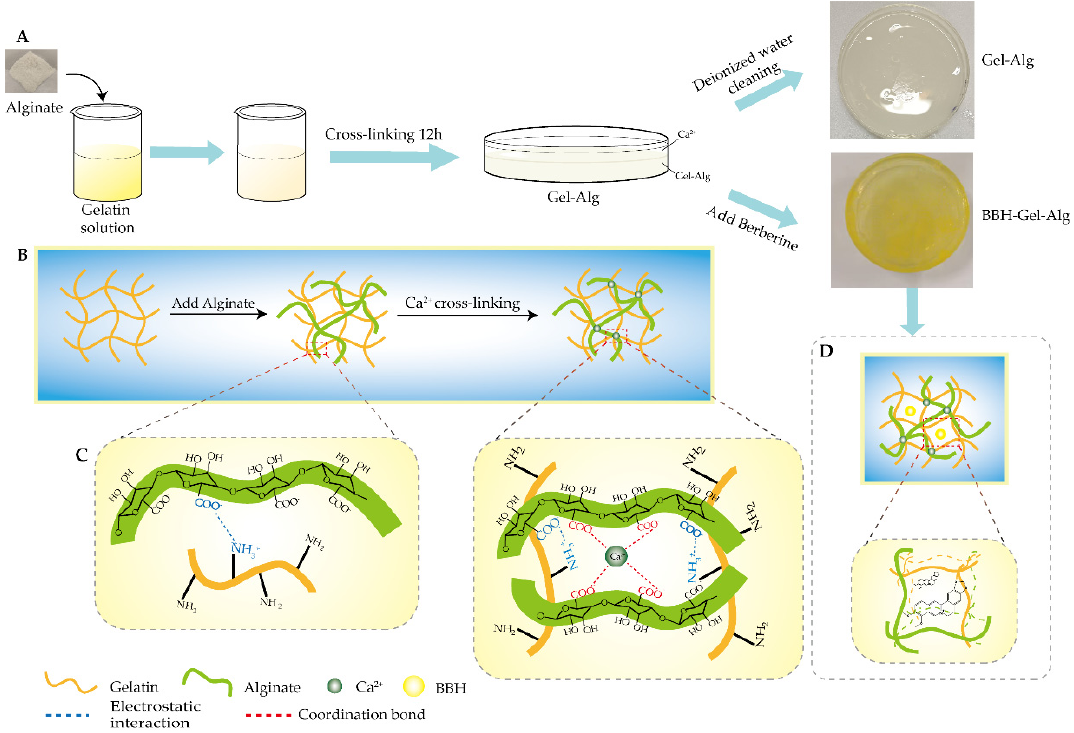
Figure 1. Preparation diagram of Gel–Alg hydrogel and double-layer network structure and interaction force of Gel–Alg hydrogel. ( A ) Preparation process of Gel–Alg hydrogel and BBH–Gel–Alg hydrogel; ( B ) Complex double-layer network structure formed by crosslinking of gelatin, sodium alginate and calcium ions; ( C ) Electrostatic interaction between gelatin and sodium alginate, and the coordination bond between Ca 2+ and sodium alginate; ( D ) Double-layer network structure and three-dimensional structure of BBH–Gel–Alg hydrogel.